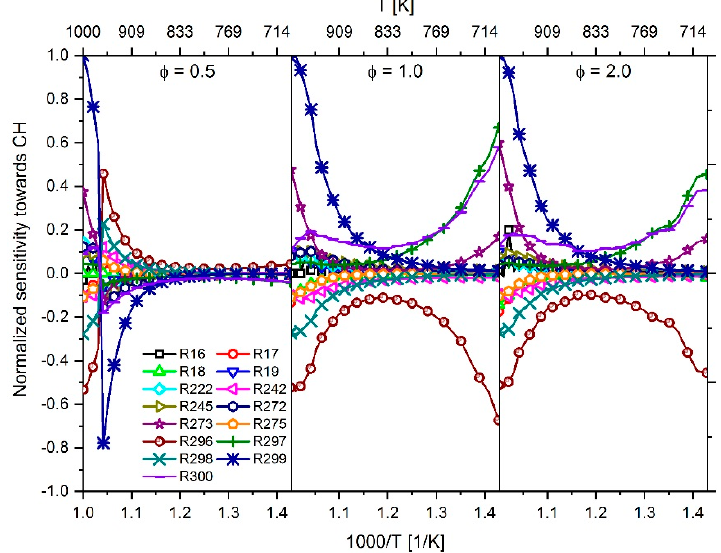
Figure 16. Temperature-dependent sensitivity towards CH of the most sensitive reactions using an